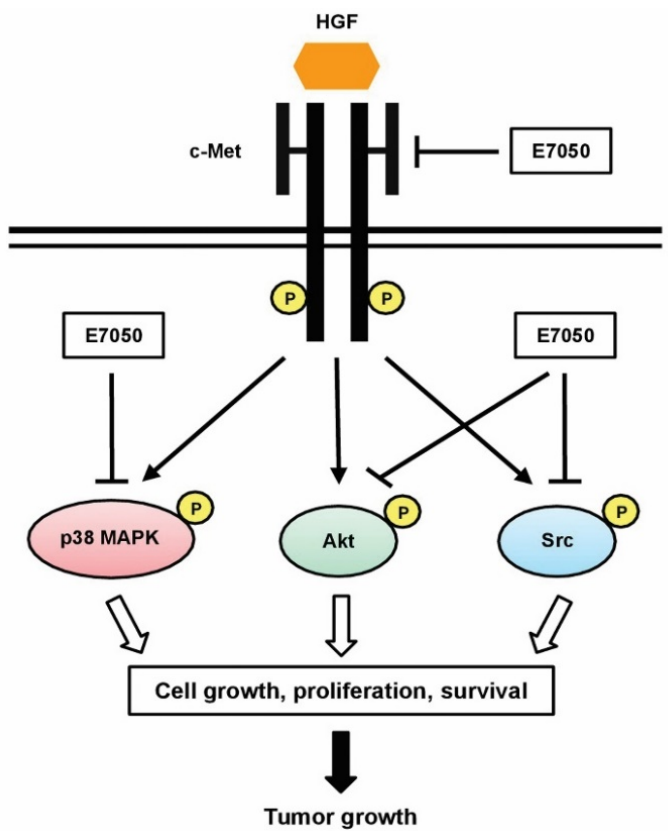
Figure 8. Pathway diagram presenting E7050 mode of action associated with tumor growth inhibition of MES-SA/Dx5 cancer cells. E7050 could inhibit the phosphorylation of c-Met (the receptor of HGF), thereby inhibiting the HGF-activated p38 MAPK, Akt and Src signaling pathways, and further reducing the growth of MES-SA/Dx5 tumor cells.